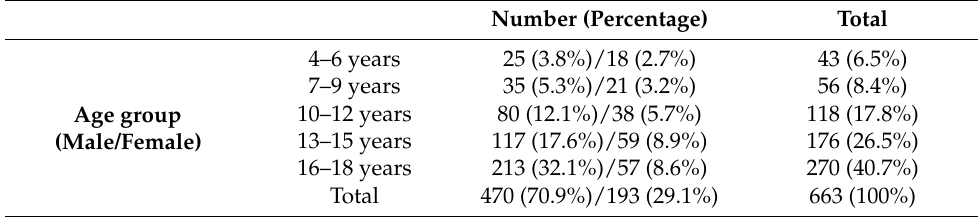
Table 1. Composition of the study population by age group.